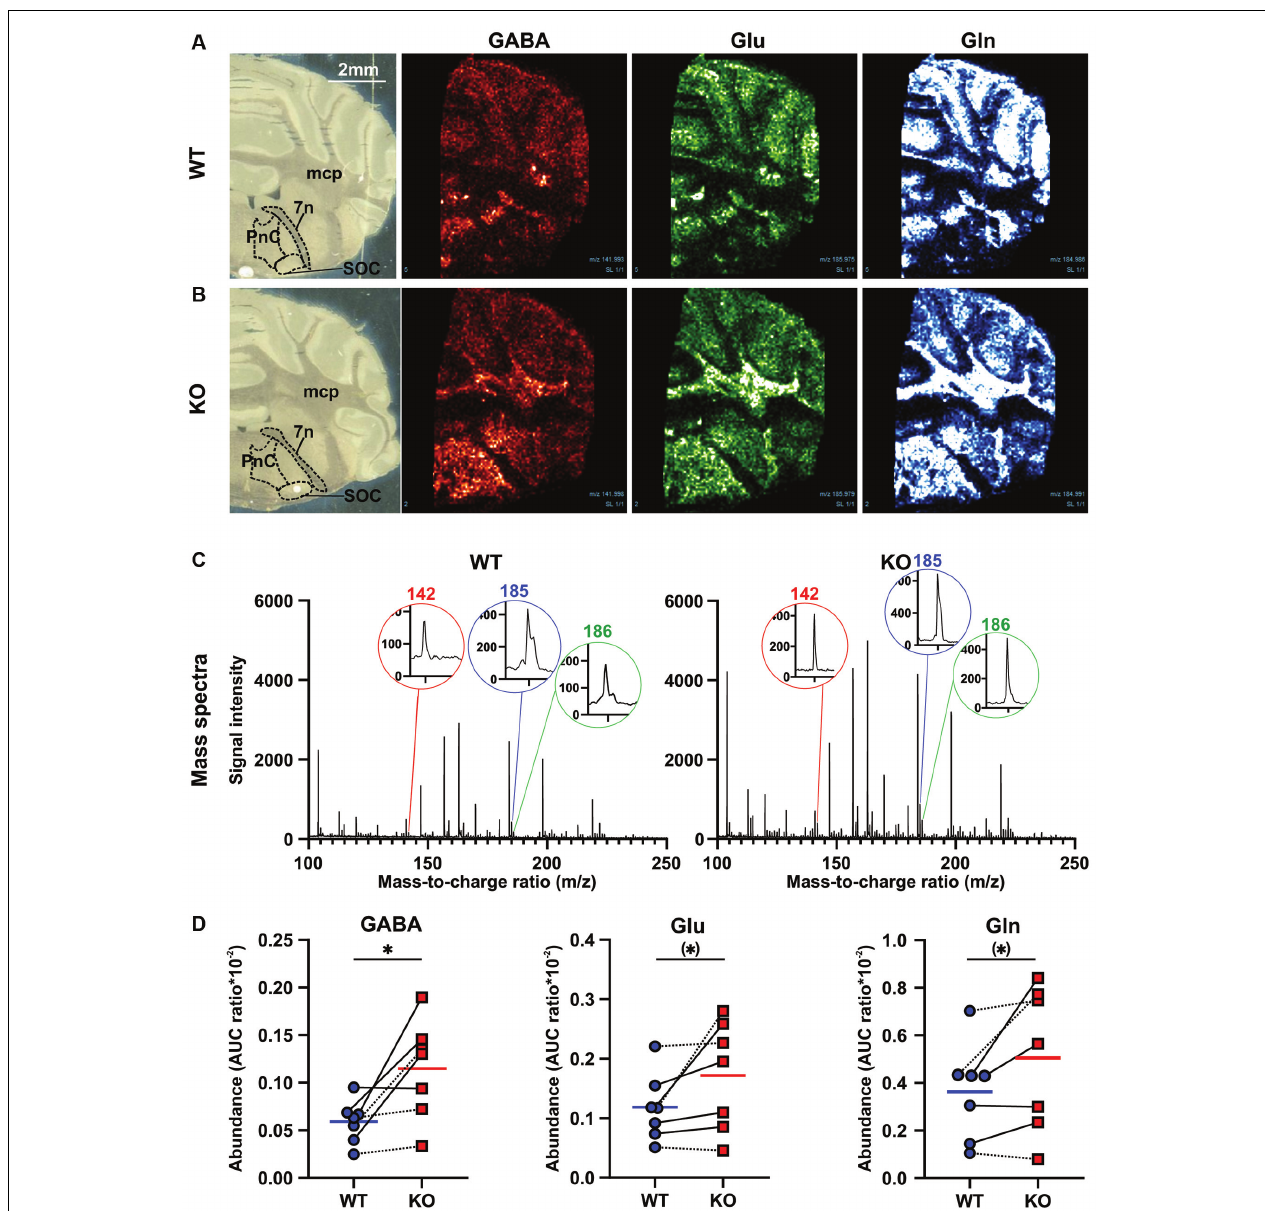
FIGURE 4 | Effect of Cntnap2 knockout on the MALDI MS signals of amino acids in fresh frozen rat brain tissue. MALDI-MS generated intensity maps of GABA ([GABA+K] + : 142m/z), glutamate ([Glu+K] + : 186 m/z), and glutamine ([Gln+ K] + : 185m/z) from a (A) Cntnap2 WT and (B) KO rat. The signal of GABA, Glu, and Gln appears to be enhanced in the brainstem including and surrounding the PnC and in the mcp region in Cntnap2 KO rats. (C) Mass spectra from the PnC region of interest acquired on a Cntnap2 WT ( Left ) and KO ( Right ) rat coronal brain slice with ZnO in the mass region 100–250. Mass peaks corresponding to neurotransmitters ([GABA+K] + : 142m/z, [Glu+K] + : 186m/z, [Gln+ K] + : 185m/z) were acquired from each mass spectra. (D) The degree of signal enhancement in the PnC region can be seen through pairwise comparative under the curve analysis for Cntnap2 KO rats ( n = 7, red squares and horizontal line) compared with WT controls ( n = 7, blue circles and horizontal line). The area under the curve (AUC) ratio was significantly enhanced for GABA ( Left , paired t -test p = 0.0242), and by tendency for Glu ( Middle , paired t -test p = 0.0858) and Gln ( Right , paired t -test p = 0.0703). Dotted lines denote female, solid lines male WT-KO pairs. Abbreviations: PnC, nucleus reticularis pontis caudalis; mcp, middle cerebellar peduncle; 7n, facial nerve. Scale bar: 2mm. ( ∗ ) p < 0.1, ∗ p < 0.05.